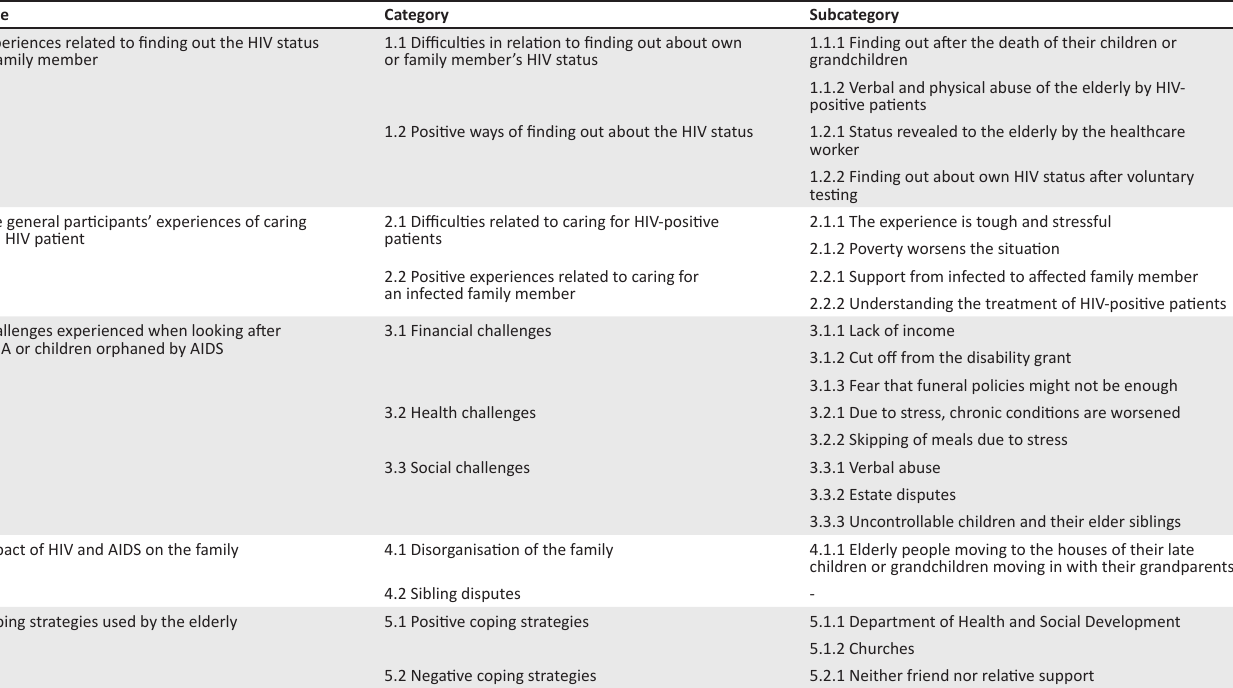
TABLE 1: Themes, categories and subcategories of the impact of HIV and AIDS on EPLWHA, according to the elderly infected by HIV or affected by AIDS.